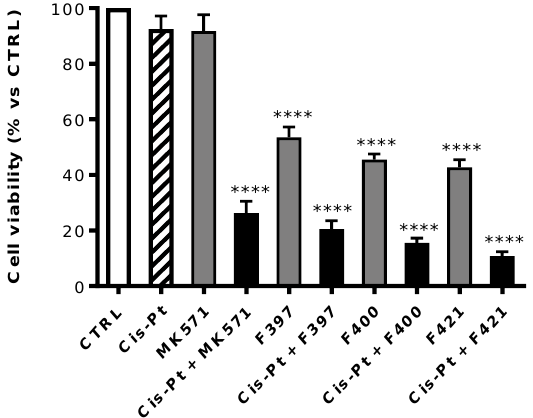
Figure 4. Antiproliferative activity on A549 / DX of MK571 and cis-Pt at 25 µ M alone and in co-administration; cis-Pt at 25 µ M and respectively F397, F400, and F421 at 10 µ M alone and in co-administration. Each bar represents the mean ± SEM of three experiments performed in triplicate. One-way analysis of variance (ANOVA) analysis: **** p < 0.0001 vs. control.